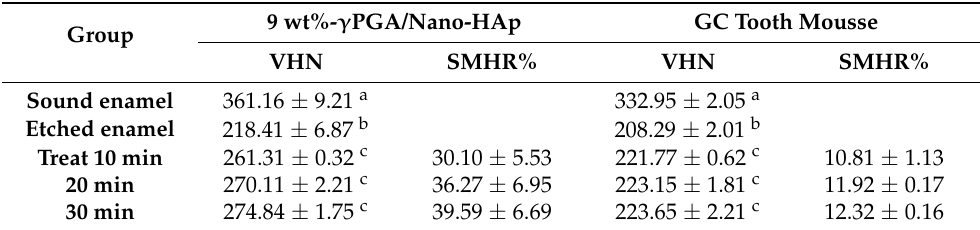
Table 1. VHN and SMHR% of γ -PGA/nano-HAp and GC Tooth Mousse ® .